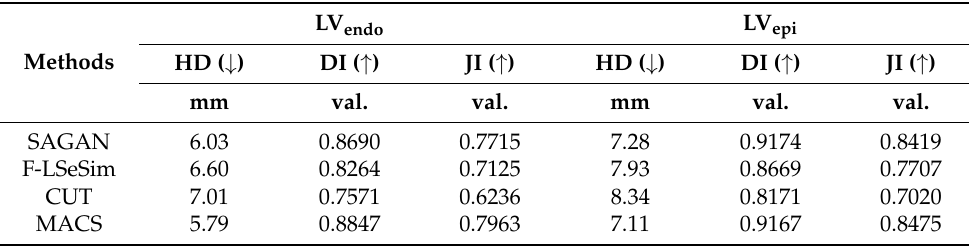
Table 3. Comparison with the segmentation performance on images translated by the SAGAN, F-LSeSim and CUT. The up arrow indicates expecting a higher value.